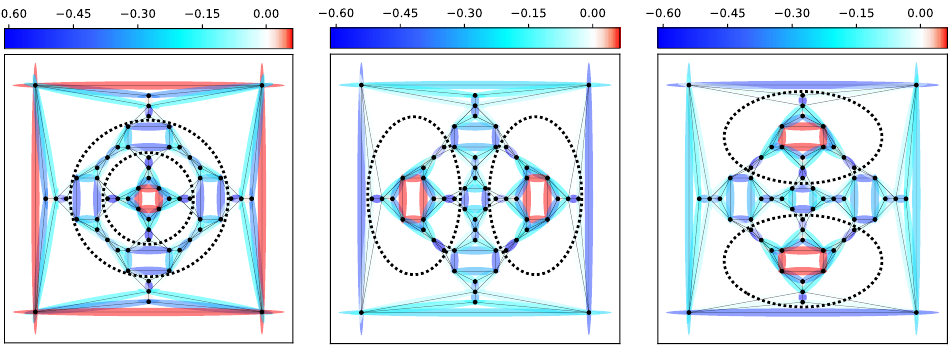
(cid:10) (cid:11) · S S for the three symmetry- i j